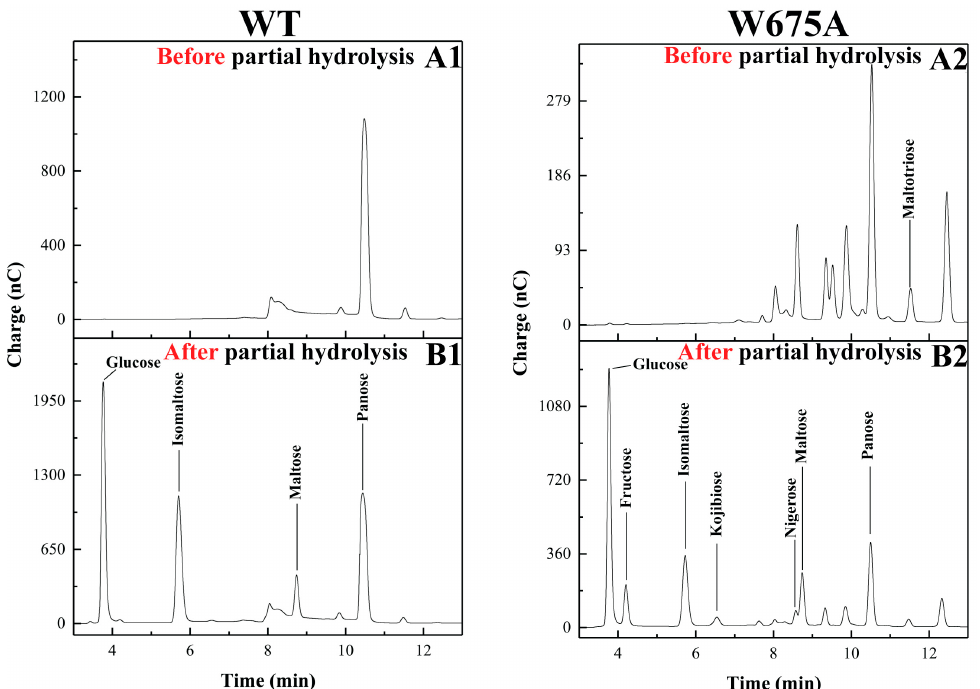
Figure 6. Partial hydrolysis of trisaccharides from maltose-acceptor reaction. ( Left panel ): products produced from WT. ( Right panel ): products from. ( A ) HPAEC-PAD profiles of the products before partial hydrolysis. ( B ) Product profiles after partial hydrolysis.